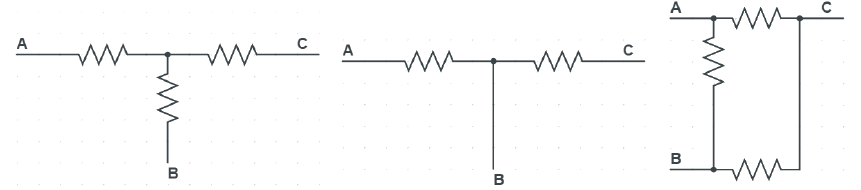
Fig. 4. ABC circuit options